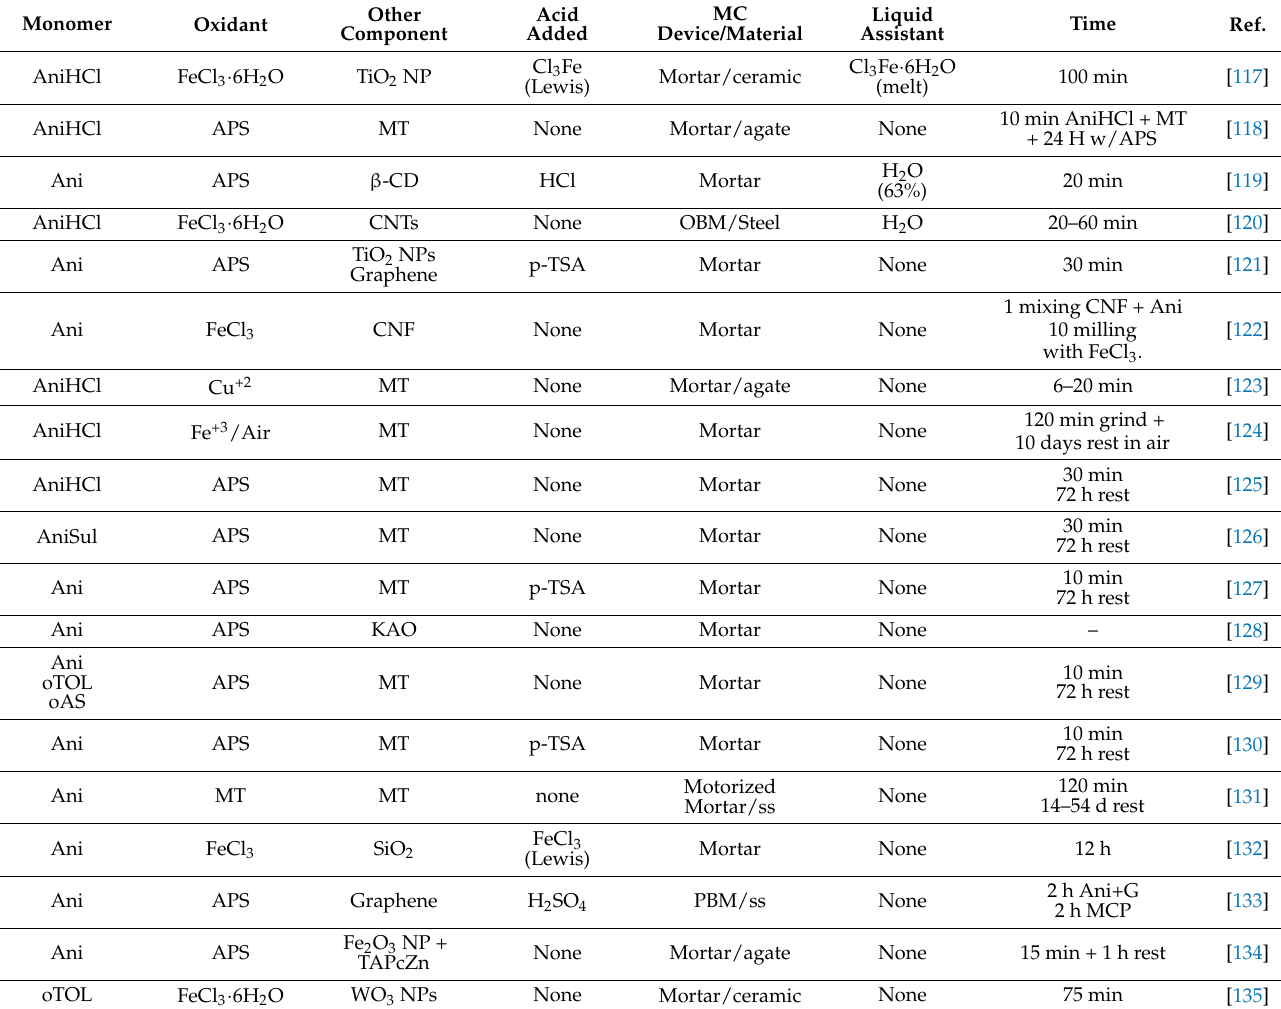
Table 6. Summary of conditions used for mechanochemical synthesis of